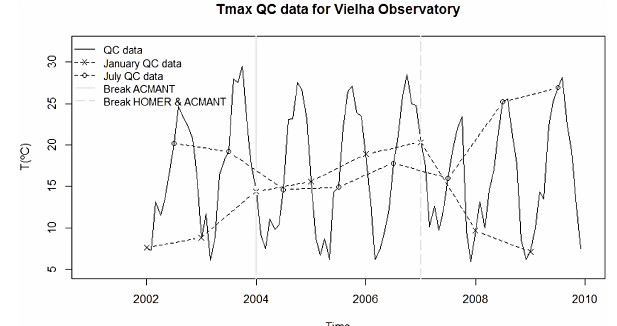
Figure 7. Vielha QC series for T max from 2002 to 2009 continuous line), January data (dashed line and asterisks) and July data (dashed line and circles). Detected breaks of ACMANT (HOMER and AC- MANT) are indicated by gray continuous (dashed) vertical